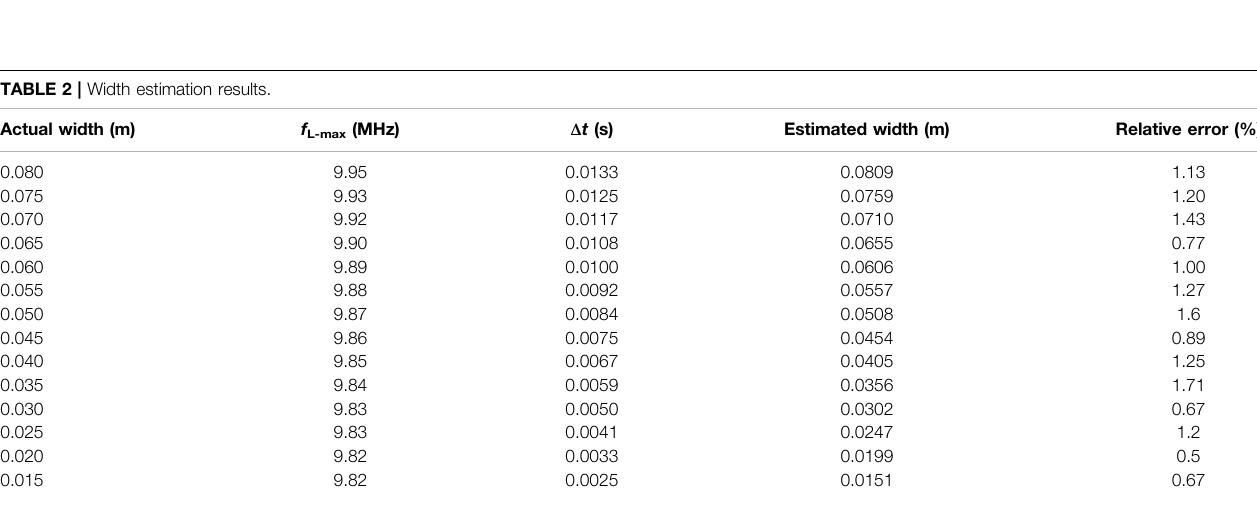
TABLE 2 | Width estimation